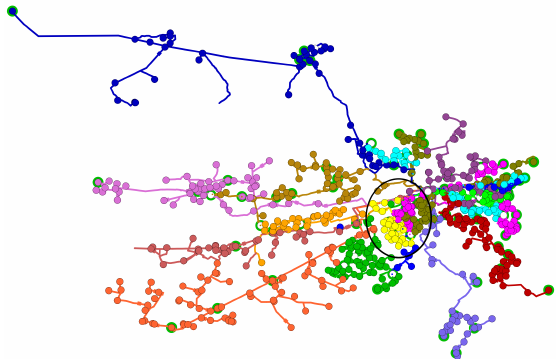
Figure 3. An example of a distribution grid.